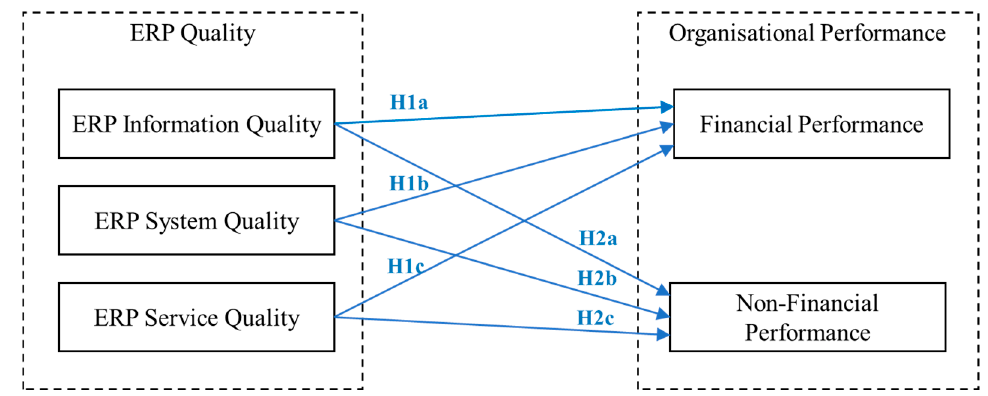
Figure 1. Research model and